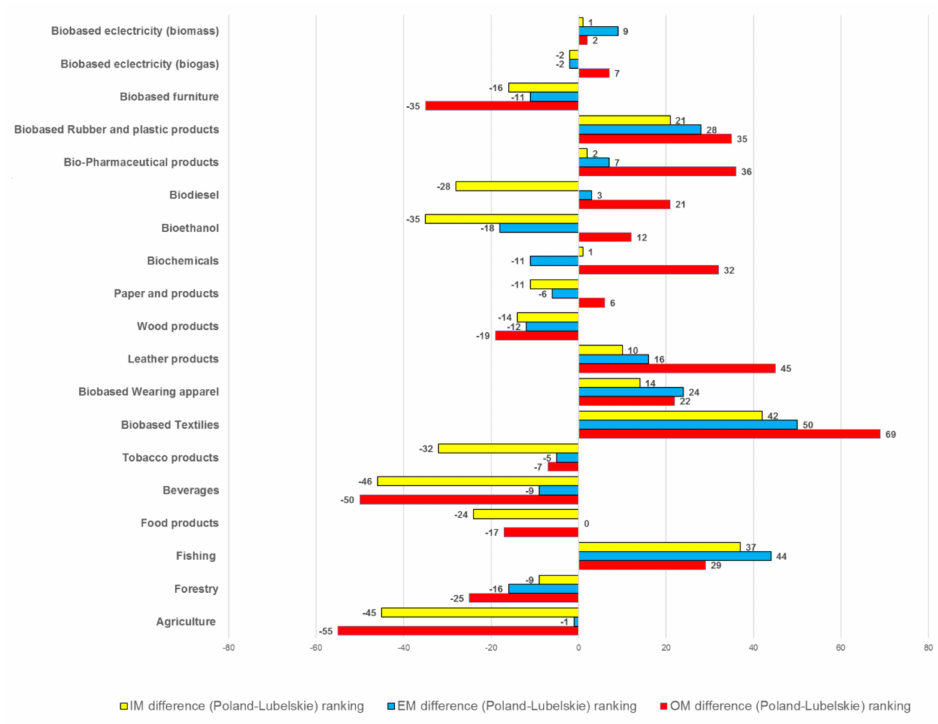
Figure 3. Difference in ranking (importance) between sectoral multipliers of the national and regional